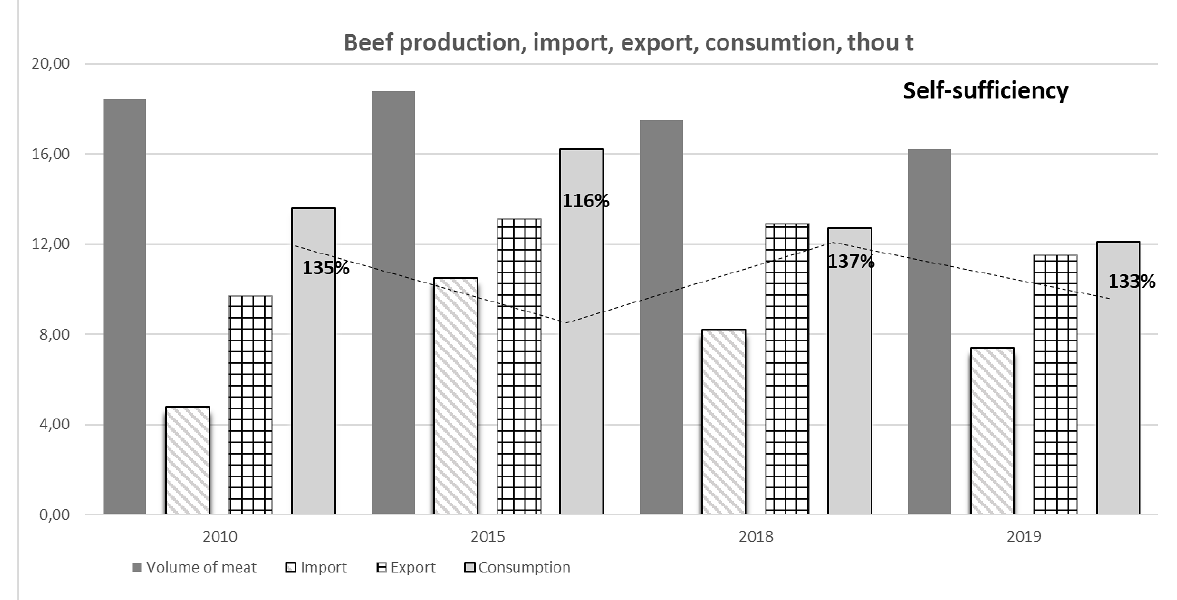
Figure 2. Beef sector in Latvia, 2010-2019